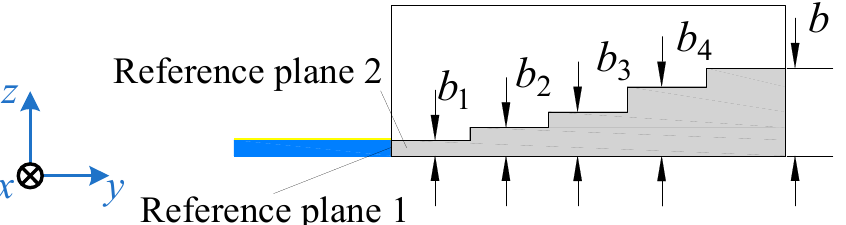
Figure 2. Vertical view of the proposed MSL-to-RWG transition, with the metallic strip area zoomed in.